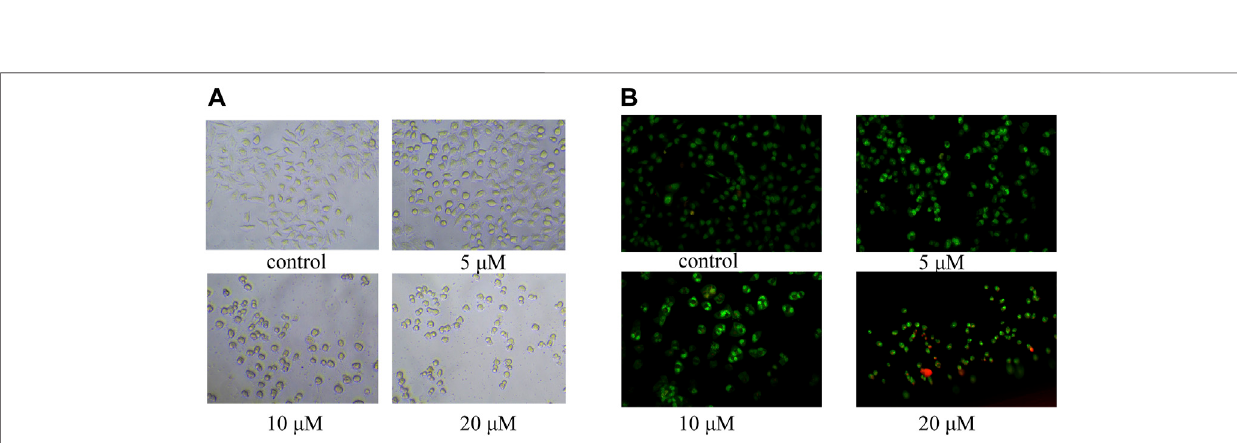
Frontiers in Chemistry |